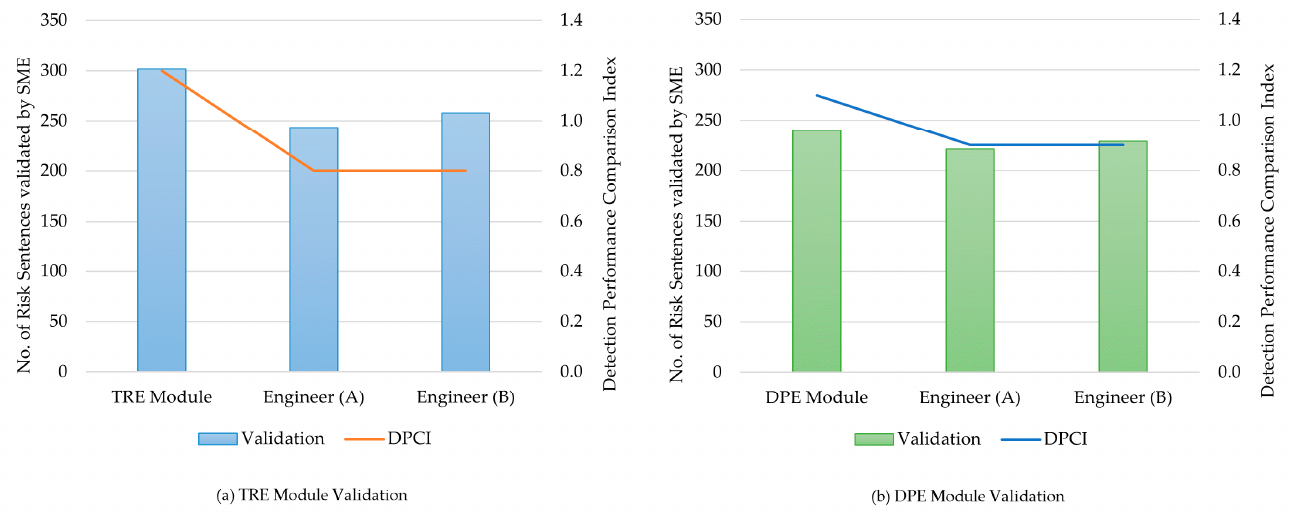
Figure 18. The validation results of the TRE and DPE modules, ( a ) TRE Module Validation; ( b ) DPE Module Validation. A total of 252 risk sentences were detected by the DPE module, whereas Engineer A and B detected 223 and 231 risk sentences, respectively. The number of common risk sentences extracted by the DPE module and two engineers was 187. There was a difference between the excluding intersection values and the total value. A total of 65 risk sentences